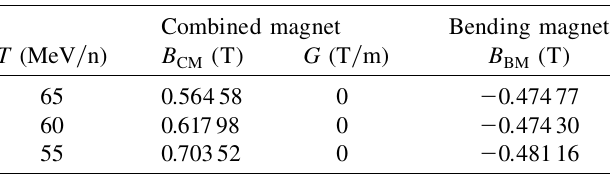
TABLE I. Focusing and bending fields for H (cid:2) ion beams. The values of focusing and/or bending parameters of the combined and bending magnets used in beam dynamic simu- lations to properly guide beams of different energies are given. For the protons originating from H (cid:2) ions, only the bending function of the combined magnet is used. Combined magnet